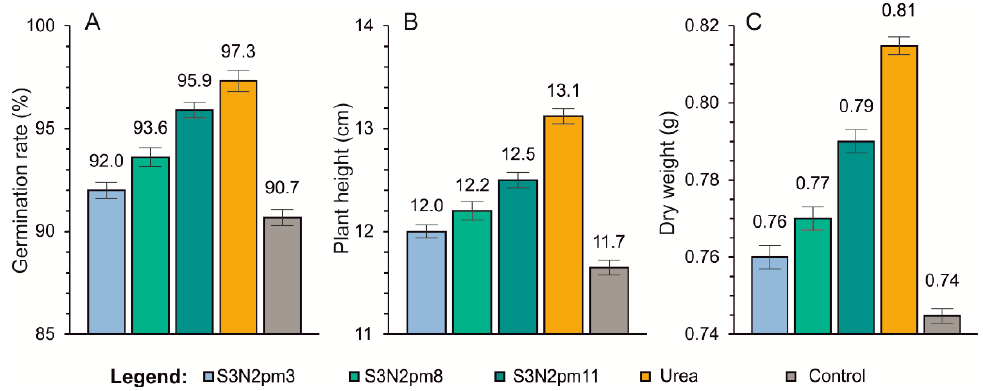
Figure 7. Histograms showing the % increase of ( A )—germination rate, ( B )—seedling height, and ( C )—dry weight of oat ( Av é na sat í va ). Note that urea and composites are equally effective fertilizers for plant growth. Further note that the composite S3N2pm11 is the most effective for plant growth as it records the maximum increase of all three parameters. The statistical significance of every parameter indicates at the p = 0.05 level. Bars represent standard